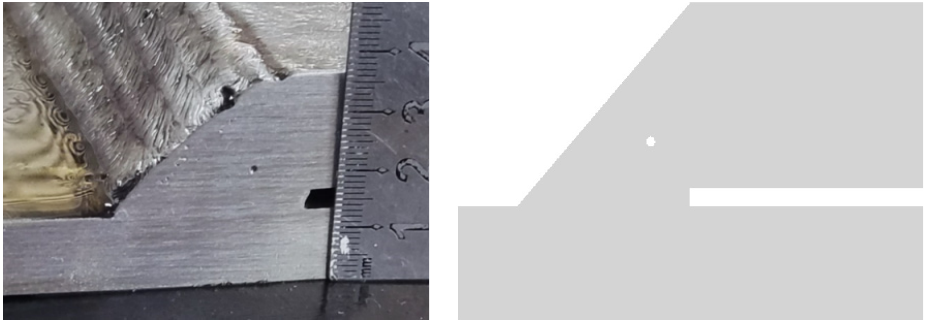
Figure 3. Specimen and numerical simulation model of the B-type sleeve. Table 2. Parameters of the simulation model.